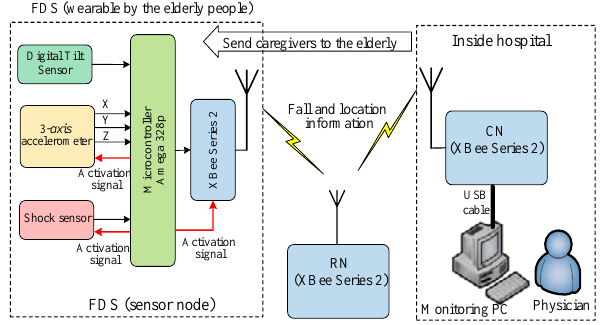
Figure 1. Topology of WSN of the subject fall and localization system. Figure 2. FDS architecture.